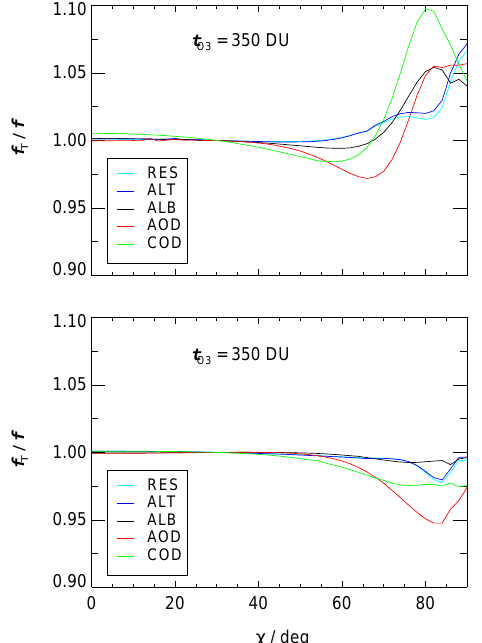
Figure 8. Solar zenith angle dependence of ratios f T /f of correc- tion factors from TUV model runs with specific changes in model parameters. Upper and lower panels show ratios for old and new interference filters, respectively. RES: spectral resolution 0.5/1nm. ALT: altitude 3000/0m. ALB: ground albedo 1.0/0.0. AOD: aerosol optical depth 1.0/0.24. COD: cloud optical depth 20.0/0.0.